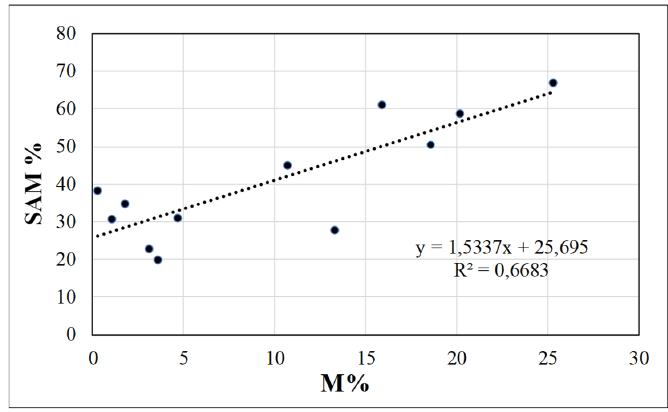
Figure 6. Regression models and R 2 of mycorrhizal colonization intensity (M, in %) vs. frequency of the “Supporting Arbuscular Mycorrhiza” weed species (SAM, in %) in young orange trees systems (No ASC and Yes ASC). Data are refer to April 2014 sampling (N = 12). In relation to the April sampling, the PCA extracted two components accounting for 50.9% of the total variability of the whole dataset (the first axis explained 34.1% of the total matrix variance). Figure 7 reports the ordination of the studied variables along Compo- nents 1 and 2. Figure 7. PCA biplot and confidence ellipses ordering the organic orange tree experimental trial relative to main weed species cover (%), frequency (%) of Polygonum aviculare (POLAV), Calendula arvensis (Vaill.) (CALAR), Diplotaxis erucoides (DIPER), Brassica nigra (BRNSI), Stellaria media (STEME), Urtica urens L. (URTUR) and Malva sylvestris L. (MALSI), Shannon–Weaver index (H), specie Richness (R), orange root mycorrhizal colonization intensity (M%), foliar SPAD and P